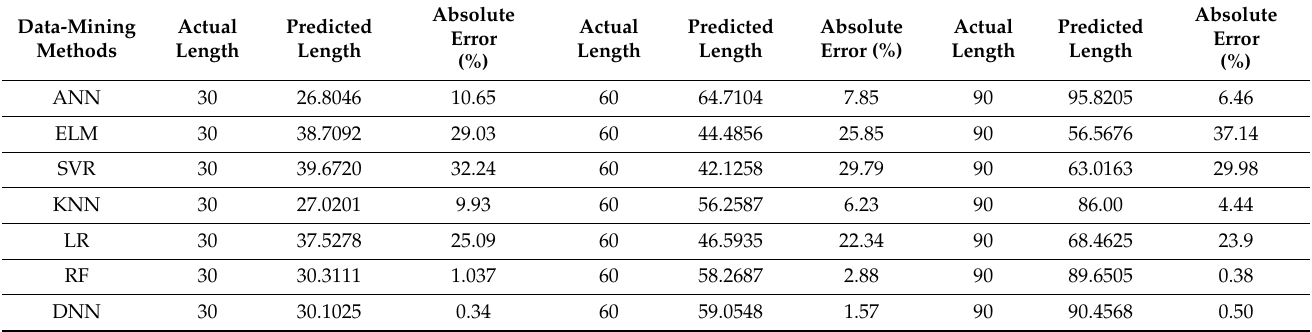
Table 12. Sample results corresponding to fault location occurred at Line-1 with R f = 0.02 ῼ